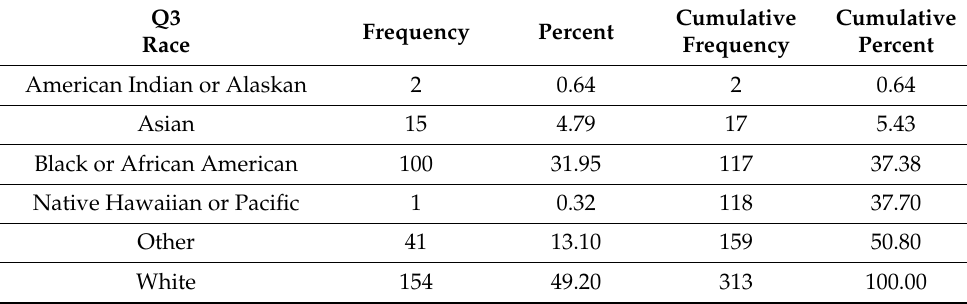
Table 2. Frequency for race.